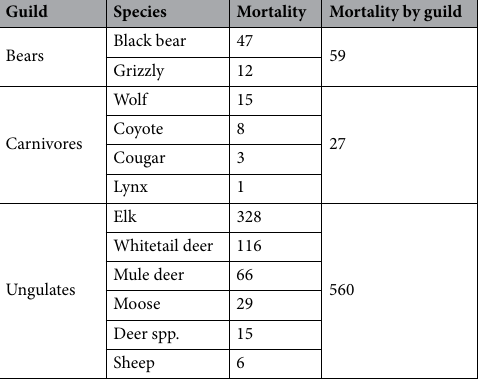
Table 1. Number of confirmed mortality events with GPS coordinates for each species on the railway through Banff and Yoho National Parks from 1995 through